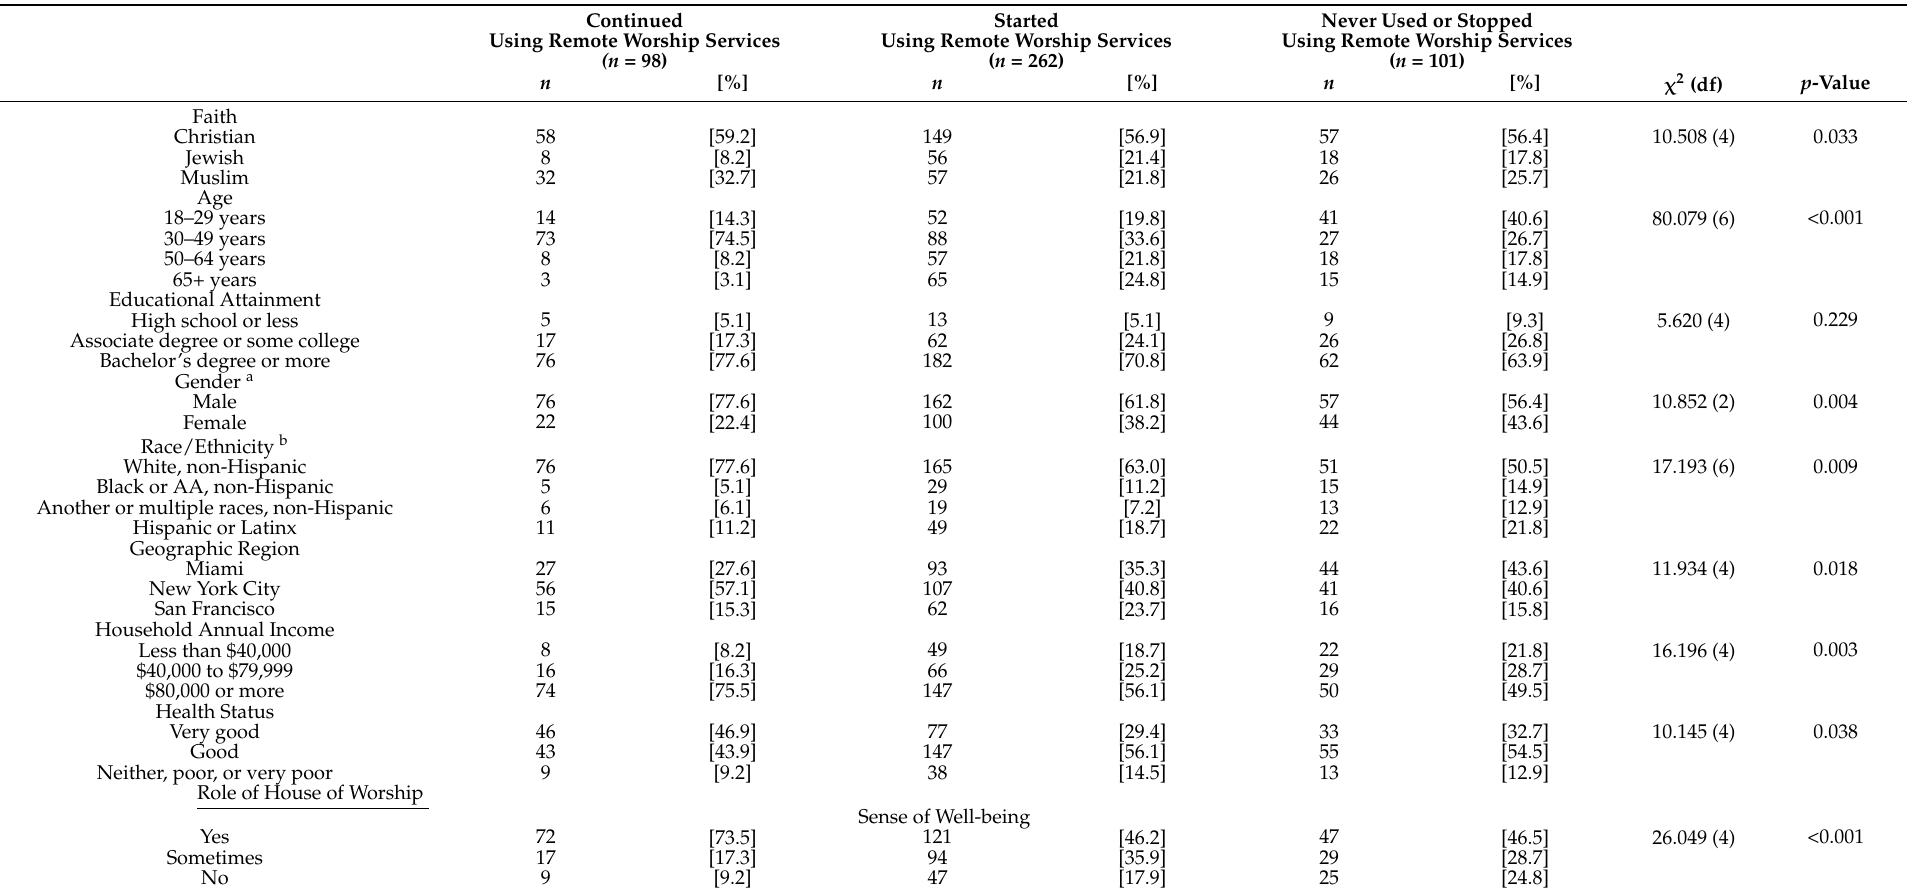
Table 1. Characteristics of study participants by utilization of remote worship services before and during COVID-19 pandemic among religious adults who were offered remote worship services ( n =